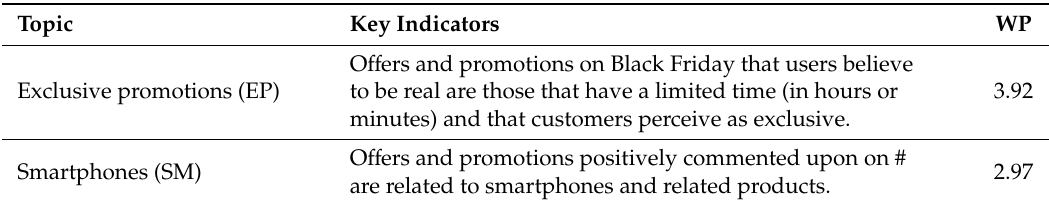
Table 5. Textual analysis (TA) indicators of positive topics.